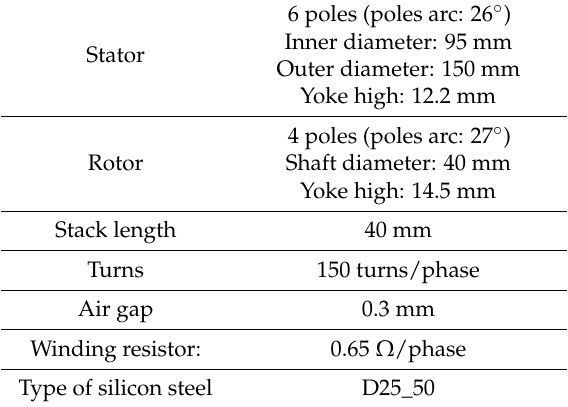
Table A1. Parameters of the studied SRM